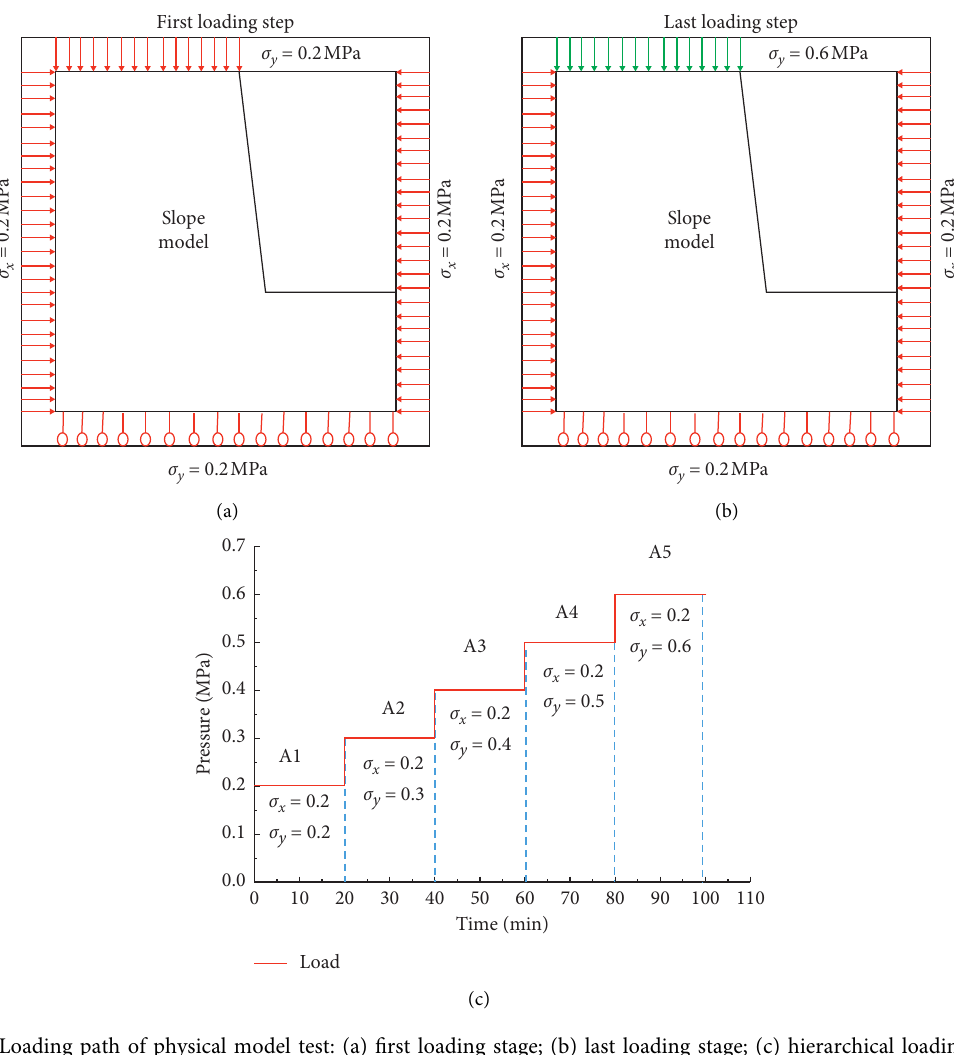
Figure 6: Loading path of physical model test: (a) first loading stage; (b) last loading stage; (c) hierarchical loading diagram.